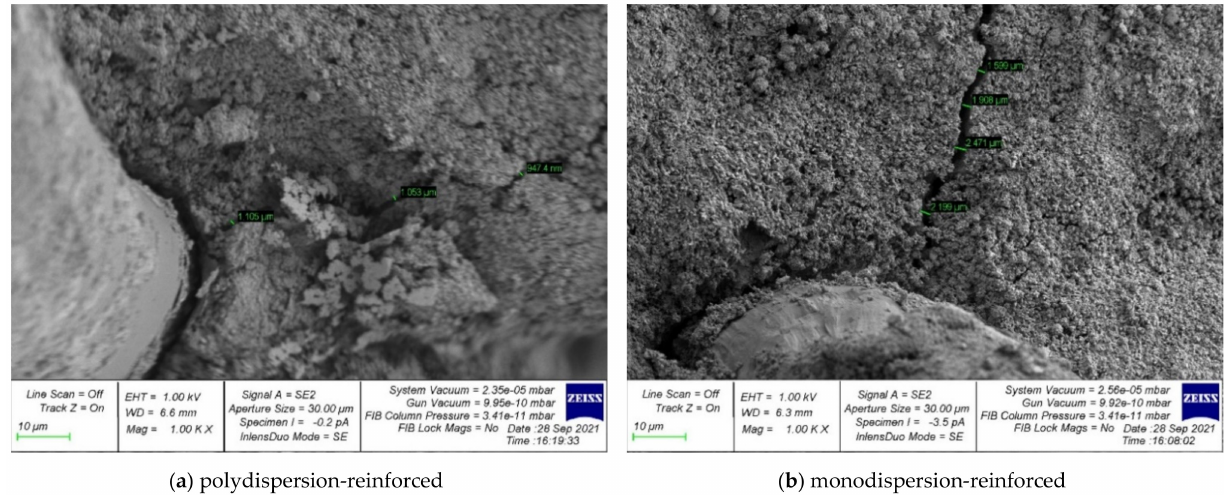
Figure 8. The microstructure of cracks in dispersion-reinforced fiber cement specimens.